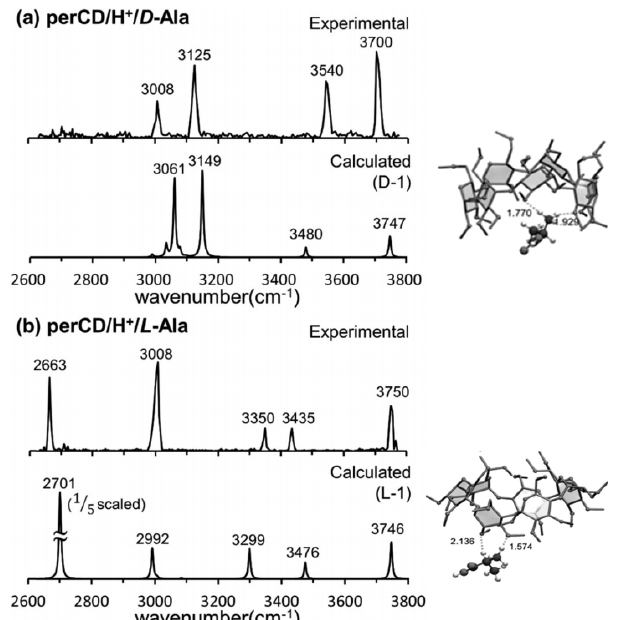
Figure 7. Experimental IRMPD and calculated absorption spectra of the protonated complex ions of permethylated CD (perCD) and ( a ) D -Ala and ( b ) L -Ala [50]. The structures of calculated isomers of D-1 and L-1 with the chiral reference of perCD and enantiomers of D / L -Ala are shown in the right, respectively. Reprinted with permission from RSC.